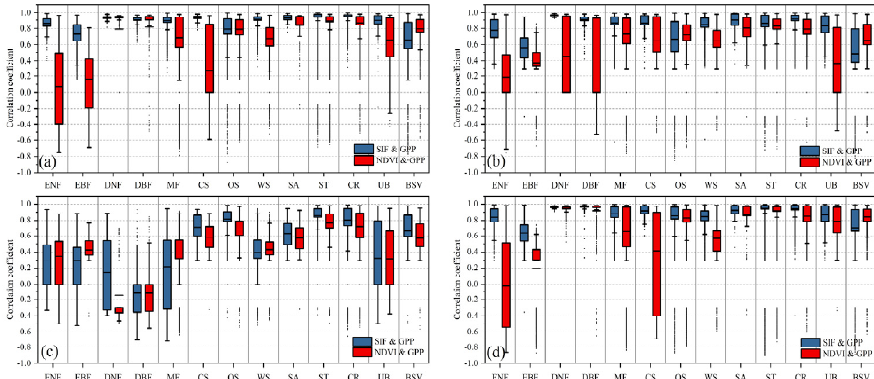
Figure 5. Correlations between SIF (NDVI) and GPP in regions with different land-cover types and in different seasons: ( a ) growing season; ( b ) spring; ( c ) summer; and ( d ) autumn.